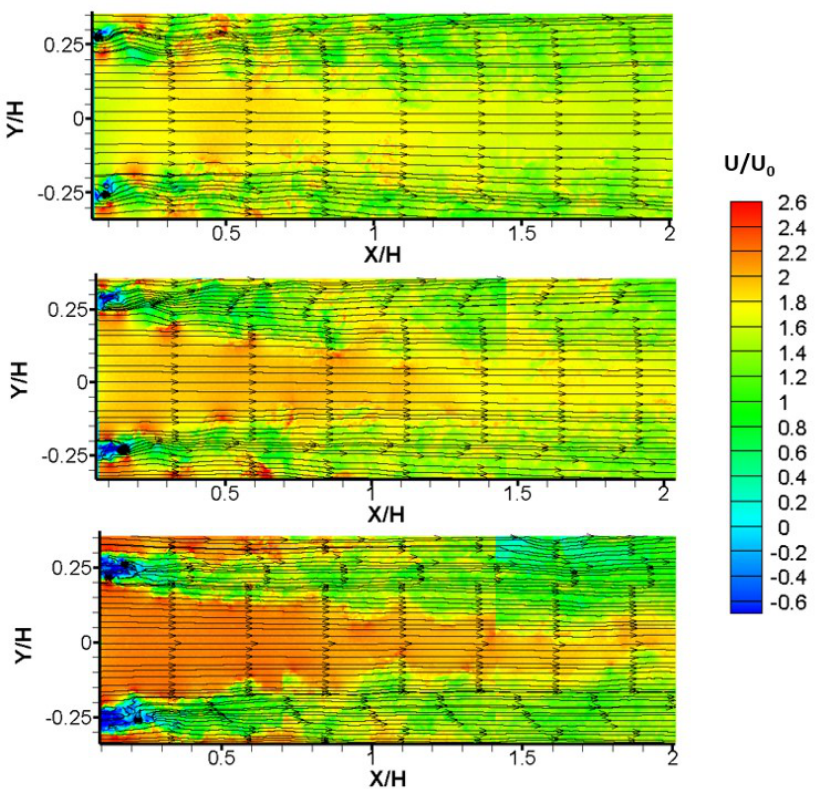
Figure 6. Streamlines of the flow in the near wake of a grid at Re = 3400. FG1, FG2 and FG4 from top to